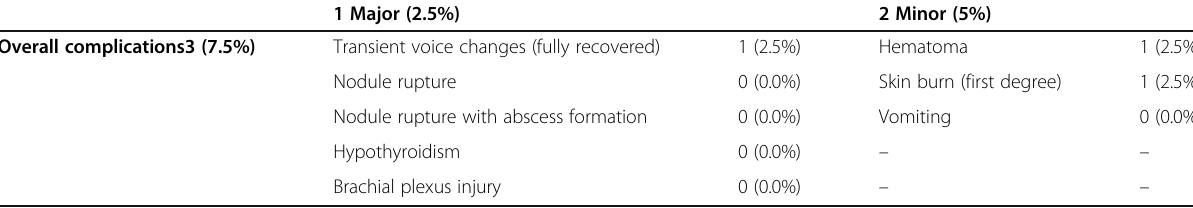
Table 6 Demonstration of complications happened in the 40 patients, no sustained or life-threating complications 1 Major (2.5%) Overall complications3